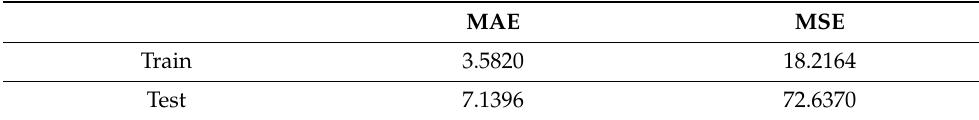
Figure 15. PSO-SVM performance on the data set. Table 4. MAE and MSE of the model on the data set.